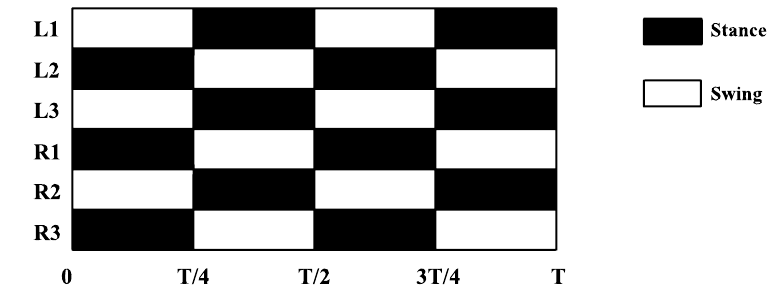
Figure 9. Sequence diagram of tripod gait.